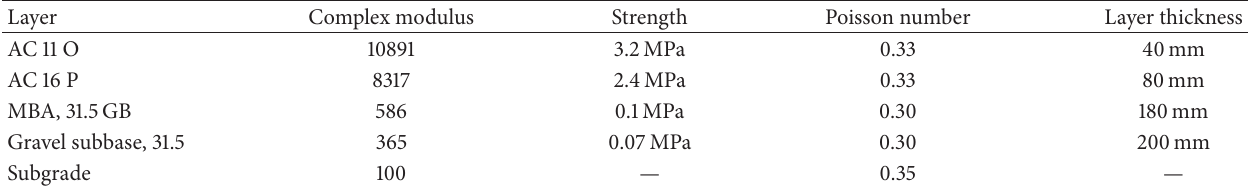
Table 1: Material characteristics of pavement layers.